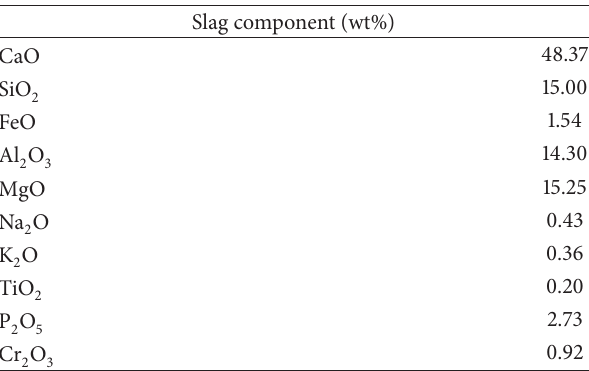
Table 1: Chemical composition of the LF slag.